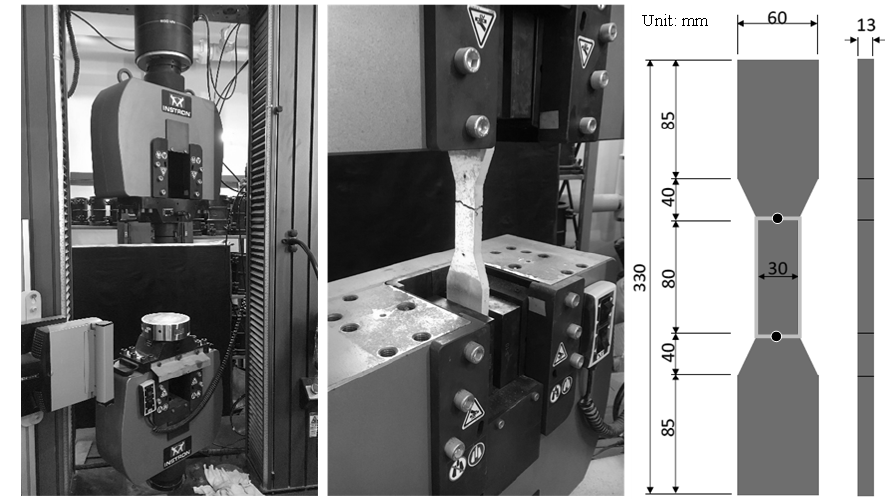
Figure 1. Tensile strength testing machine and size of the specimen.